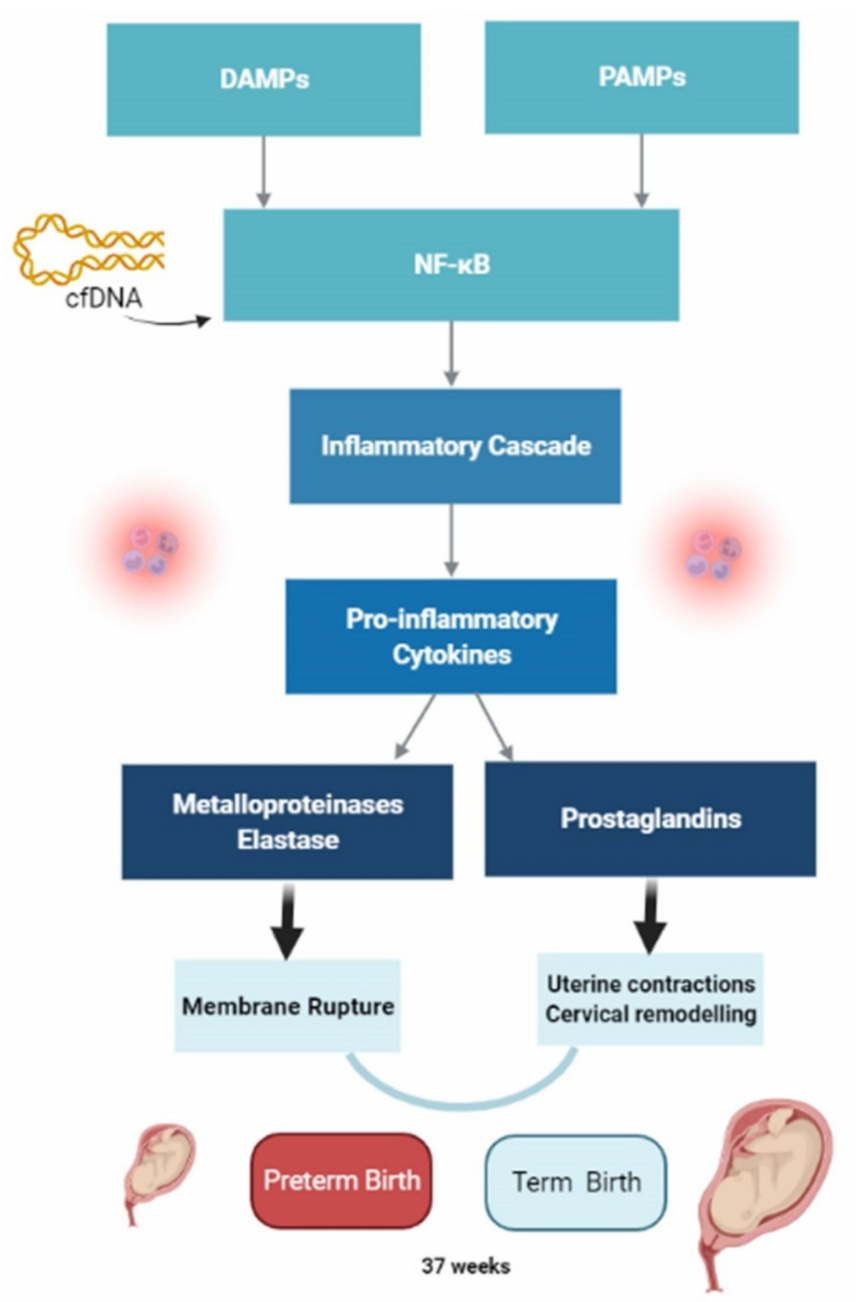
Figure 2. Pathways to labour. DAMPs: damage-associated molecular patterns; PAMPs: pathogen- associated molecular patterns; NF- κ B: nuclear factor kappa light chain enhancer of activated B cells; cfDNA: cell-free DNA. Created with BioRender.com (accessed on 3 February 2022). Inflammasomes are cytosolic protein complexes that orchestrate an inflammatory response to pathogens and endogenous danger signals. The high-mobility group box 1 protein induces an inflammatory response in chorioamniotic membranes, which is partially mediated by inflammasomes [12]. The participation of the inflammasome in labour mech- anisms related to inflammation is proven by the presence of elevated CASP1, IL-1 β and IL-18 in the amniotic fluid of women with PTB